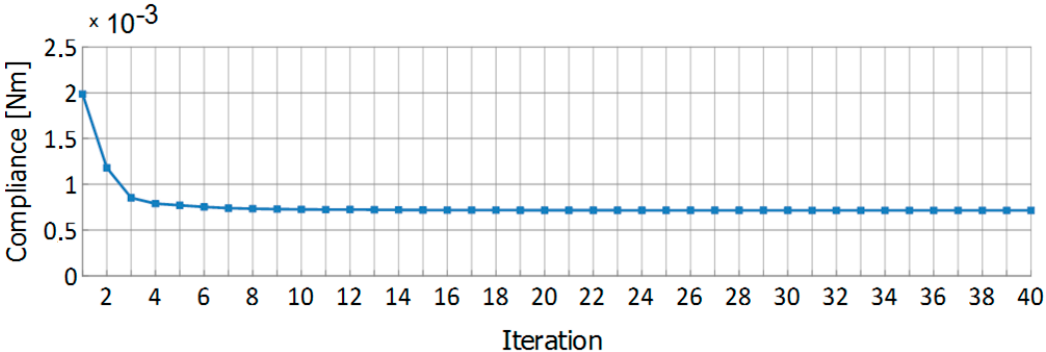
Figure 33. Iteration history for the plane structure with holes.